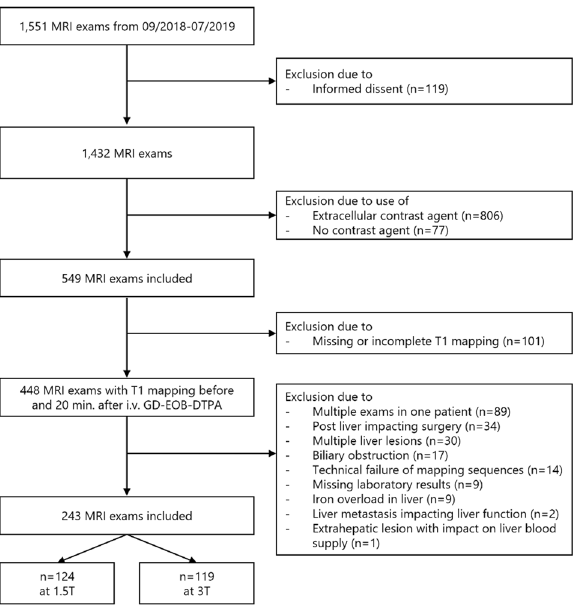
Figure 1. Patient flowchart. A total of 1551 consecutive liver MRI exams performed at our institution between 09/2018 and 07/2019 were included. After applying exclusion criteria, 243 exams with T1 mapping before and 20 min after Gd-EOB-DTPA administration remained: 124 acquired on a 1.5 T scanner and 119 acquired on a 3 T